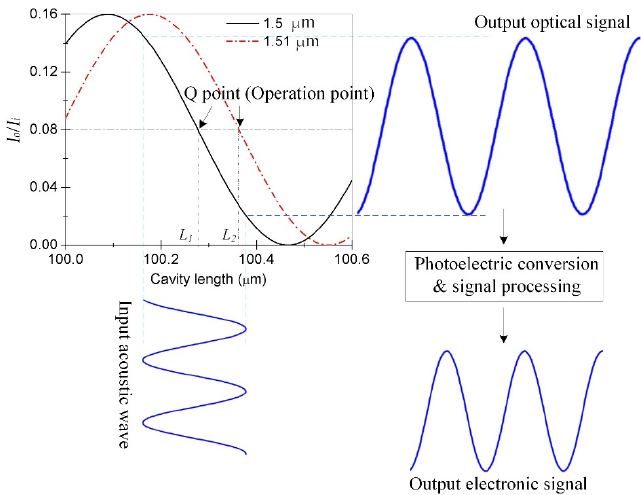
Figure 5. Formation process of the output signal of the acoustic waver sensor.